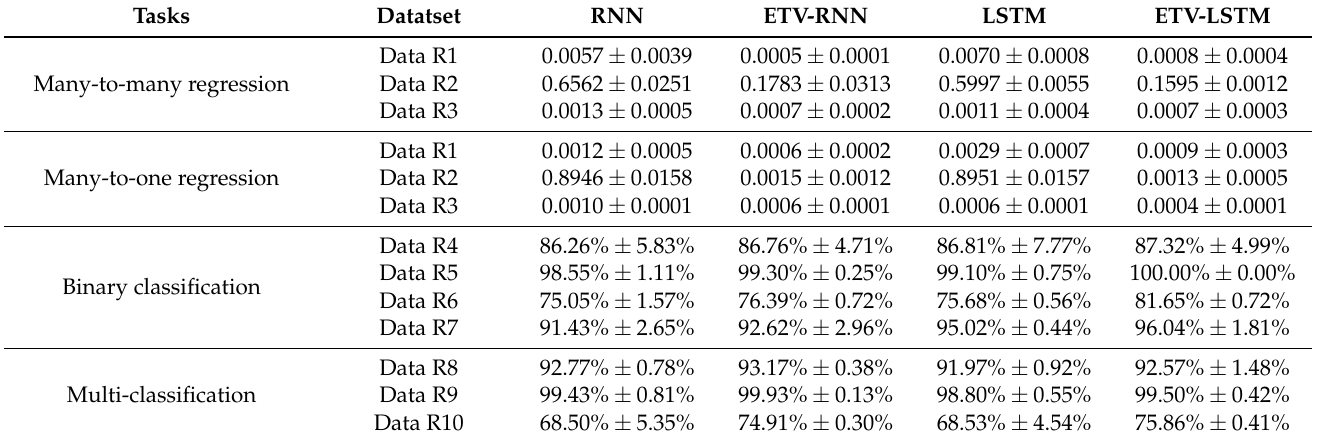
Table 4. Prediction performance of different methods on 10 real datasets (MSE for regression and accuracy for classification over five-fold